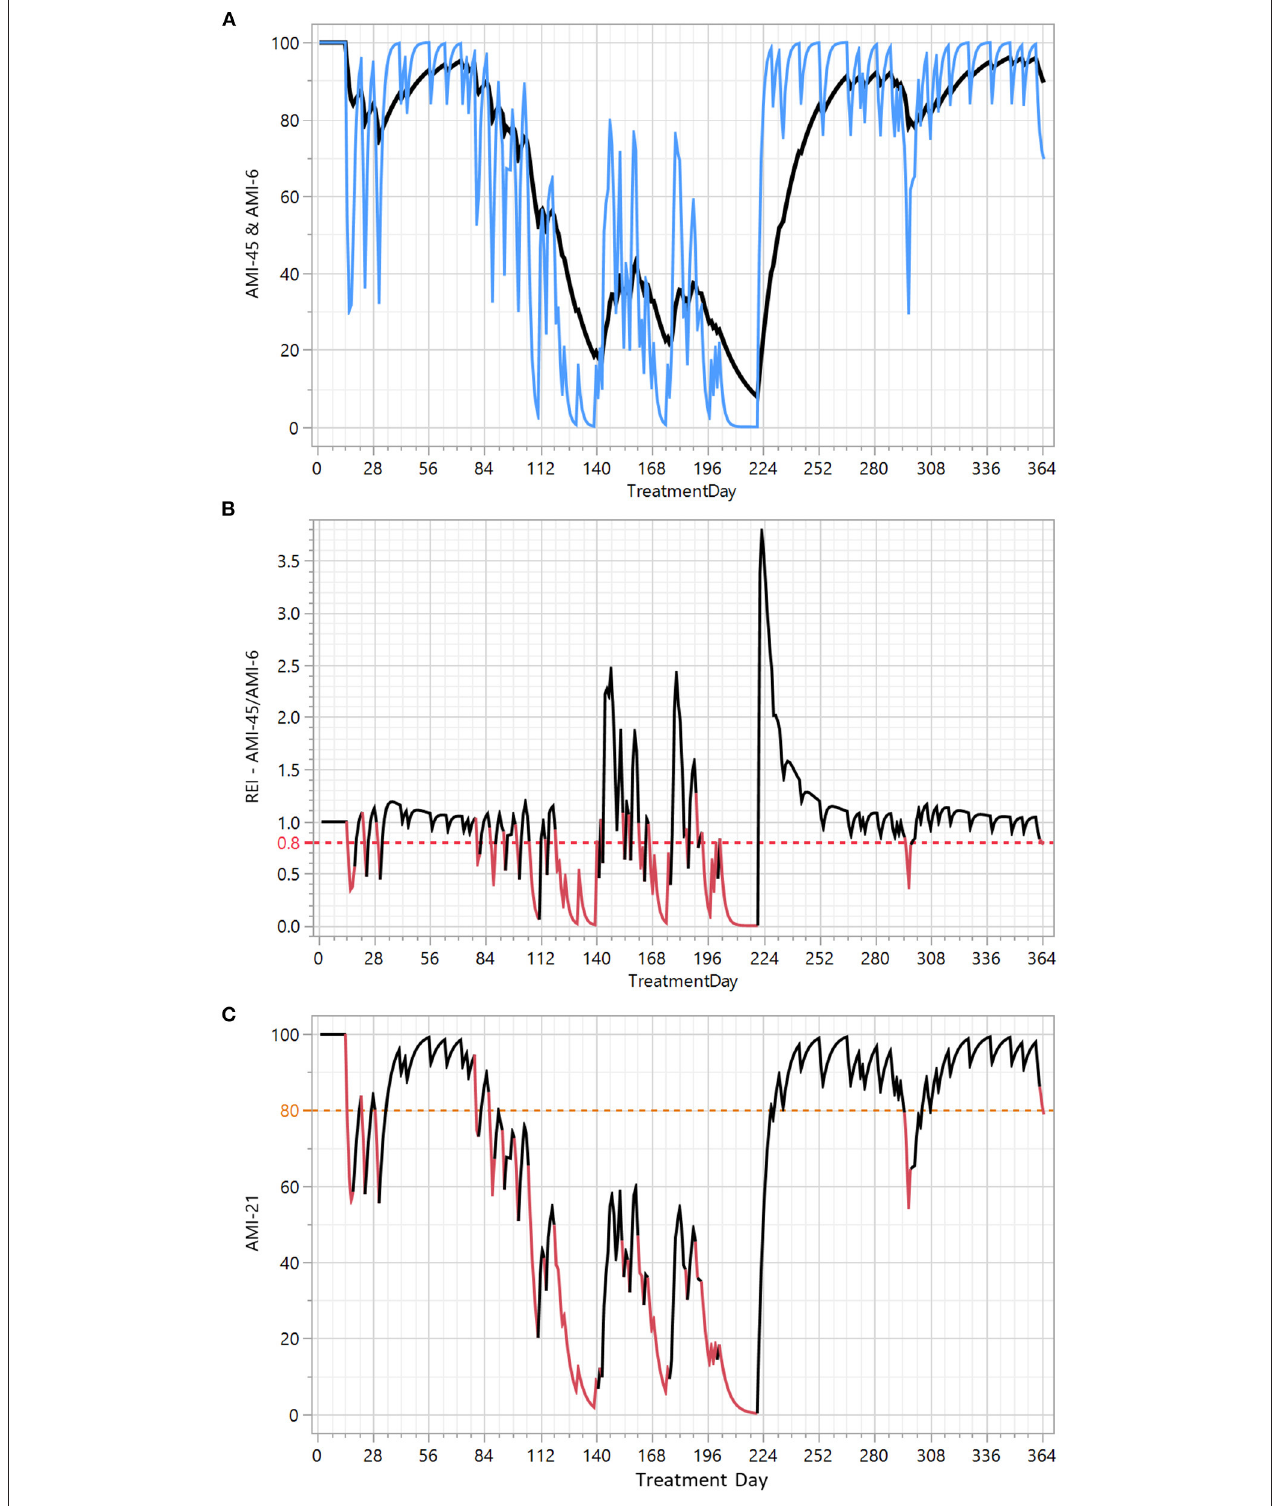
FIGURE 1 | Construction of the recovery and exacerbation index (REI) and exacerbation events (EEs) depicted with patient A. X axis: treatment time in days. Y axes: (A) The rapid variation in the clinical course is captured in AMI-45 (blue) and the baseline is defined by AMI-6 (black). (B) REI is the ratio (AMI-45/AMI-6 ratio) used to identify exacerbation events. The red line in (B) denotes the 0.8 REI threshold used for the detection of EE’s displayed as red line segments in the original addiction monitoring index (AMI-21) in (C) .